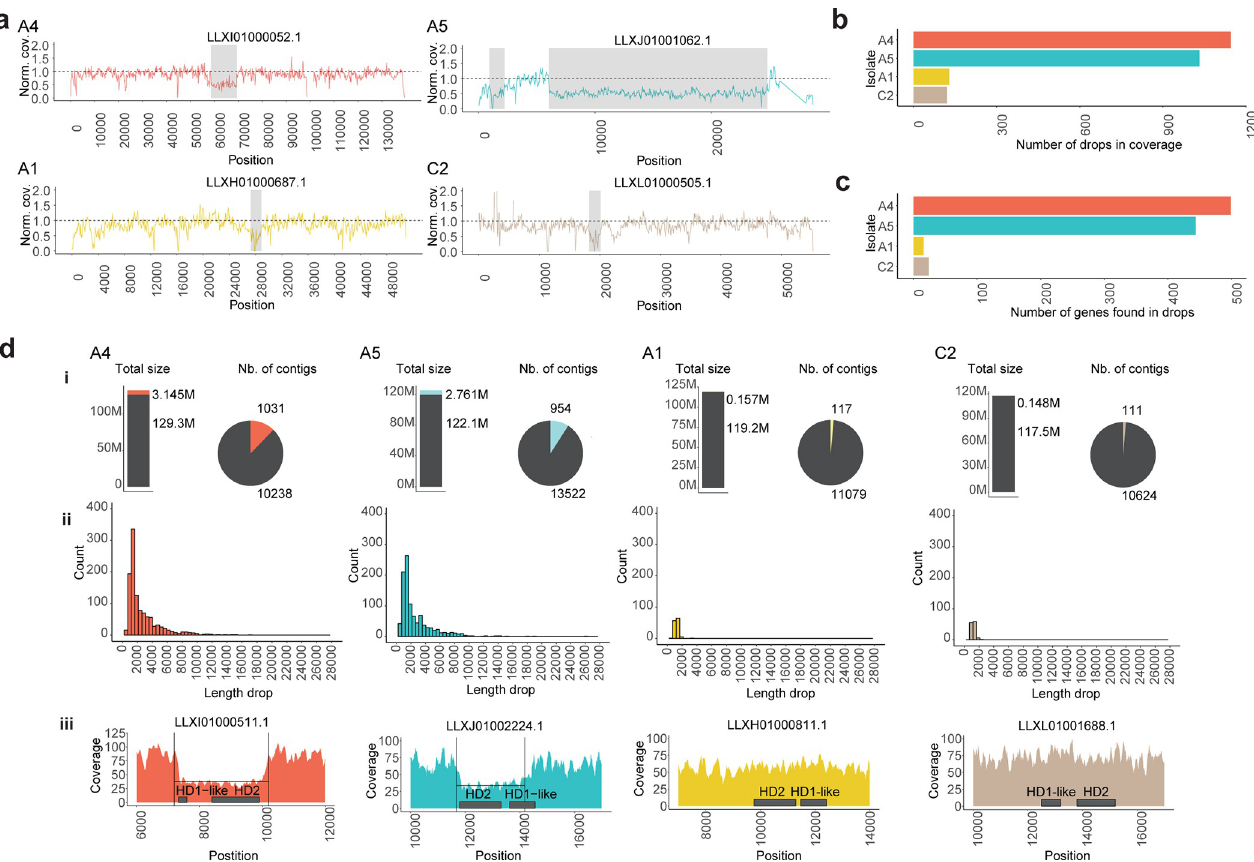
Fig 1. Drop in coverage events in isolates A4, A5, A1 and C2. a, Examples of drop in coverage events. We plotted the normalized coverage (y) per position (x). Grey rectangles represent the region detected by the algorithm. The horizontal dashed line represents the normalized coverage. b, Number of regions showing a drop in coverage that were detected in each isolate. c, Number of genes found in the regions showing a drop in coverage in each isolate. d, Summary statistics of regions showing a drop in coverage: i, proportion of total length of regions showing a drop in coverage and proportion of contigs that contain regions with a drop in coverage. ii, Histogram representing the lengths of identified regions where a drop in coverage was detected. iii, Coverage plot on the putative MAT-locus. Drop in coverage was detected in isolates A4 and A5 but not in A1 and C2.